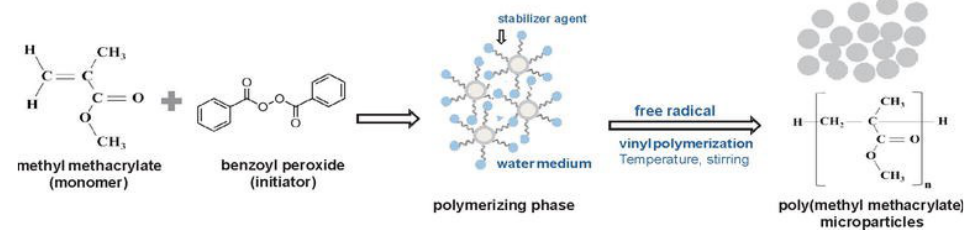
Figure 4. Chemical reaction of PMMA by cold curing process [8].